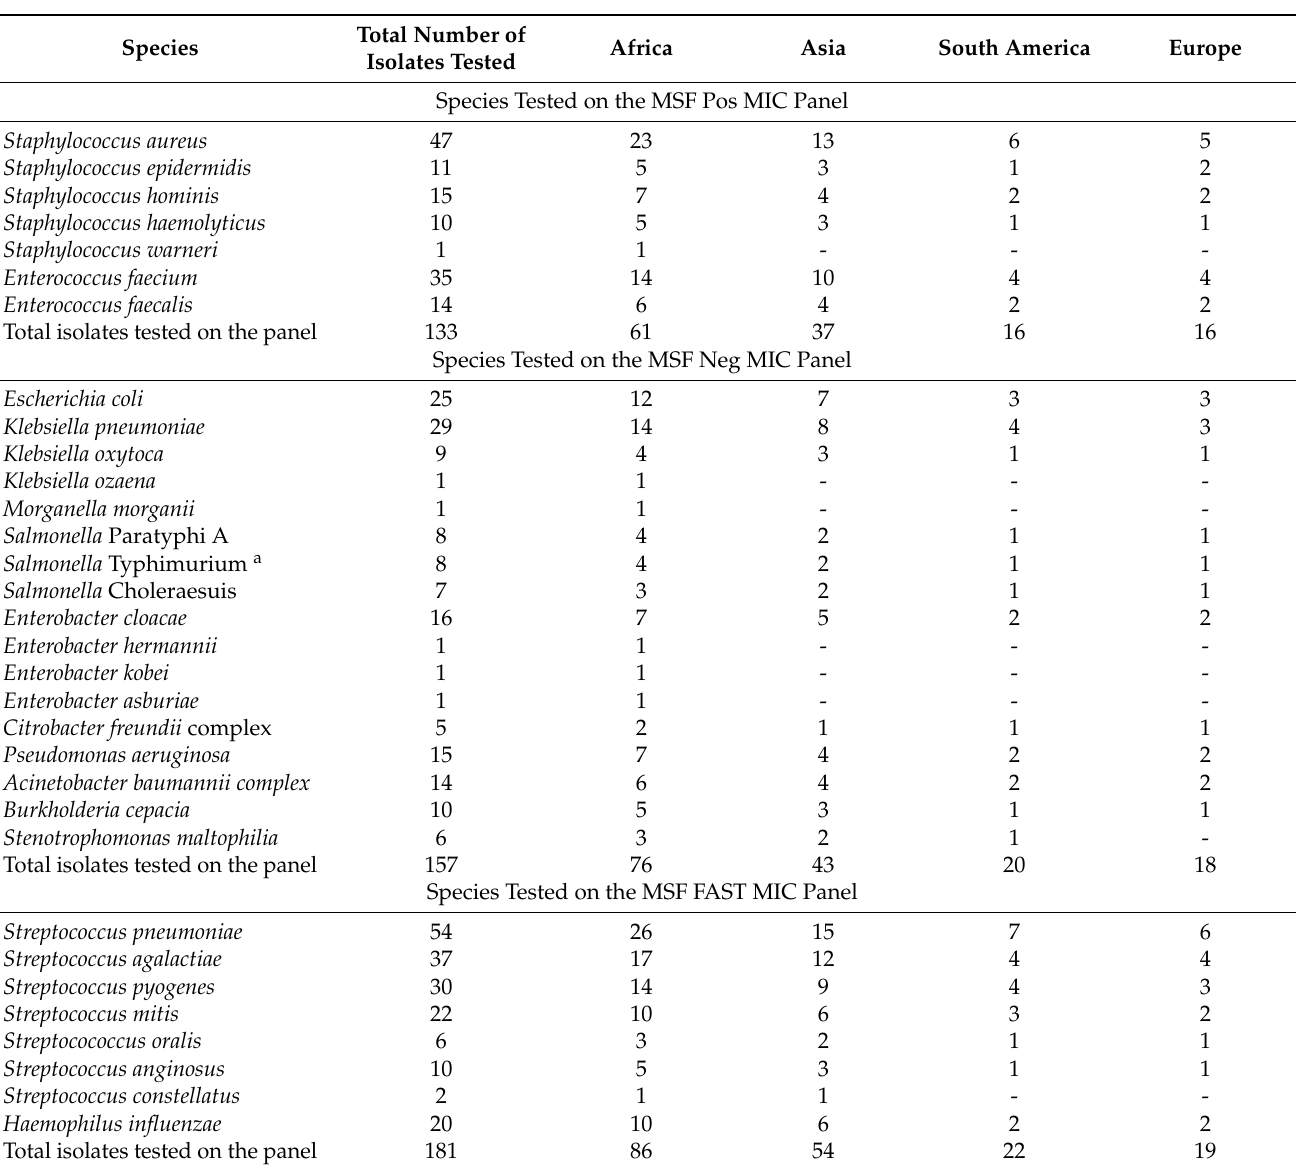
Table 1. Geographical origins of the isolates. Anonymized isolates were obtained from surveillance studies of several partners (ITM, French AMR NRL,